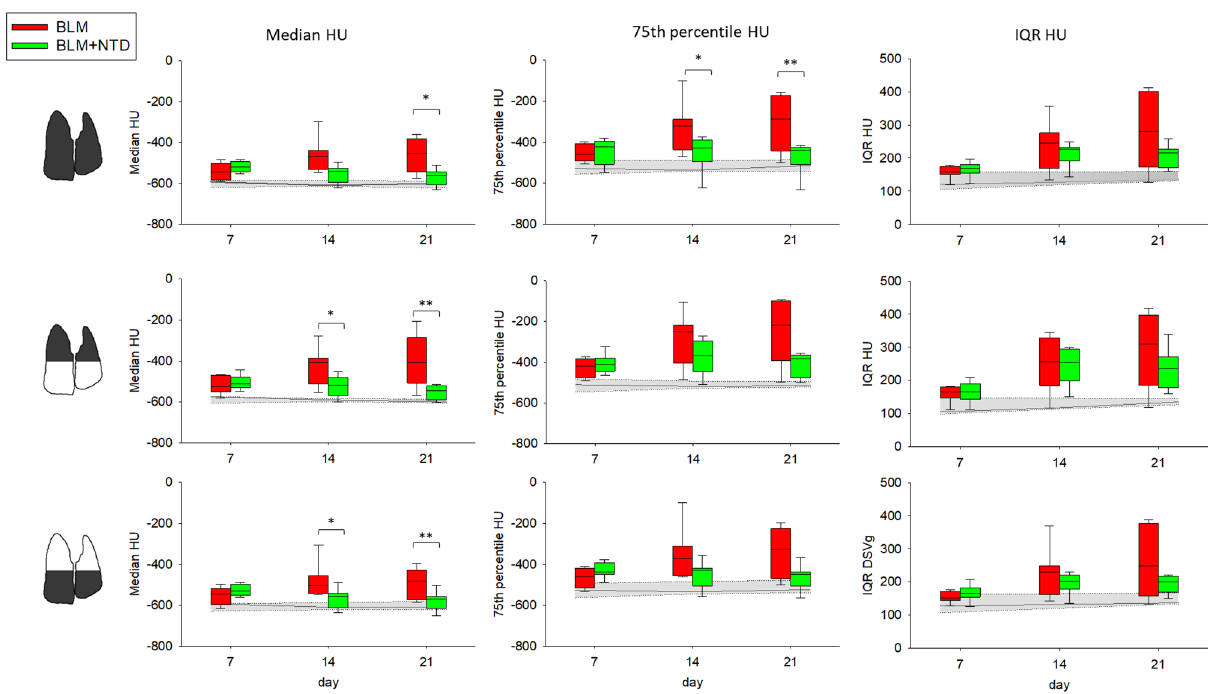
Figure 3. Median (first column), 75th percentile (second column) and IQR (third column) of HU computed in inspiration, in the BLM (red) and BLM + NTD (green) group. The analysis was performed separately for the overall lung (top row), upper lung regions (middle row) and lower lung regions (bottom row). Gray area represents the saline values and is delimited by the 25th and the 75th